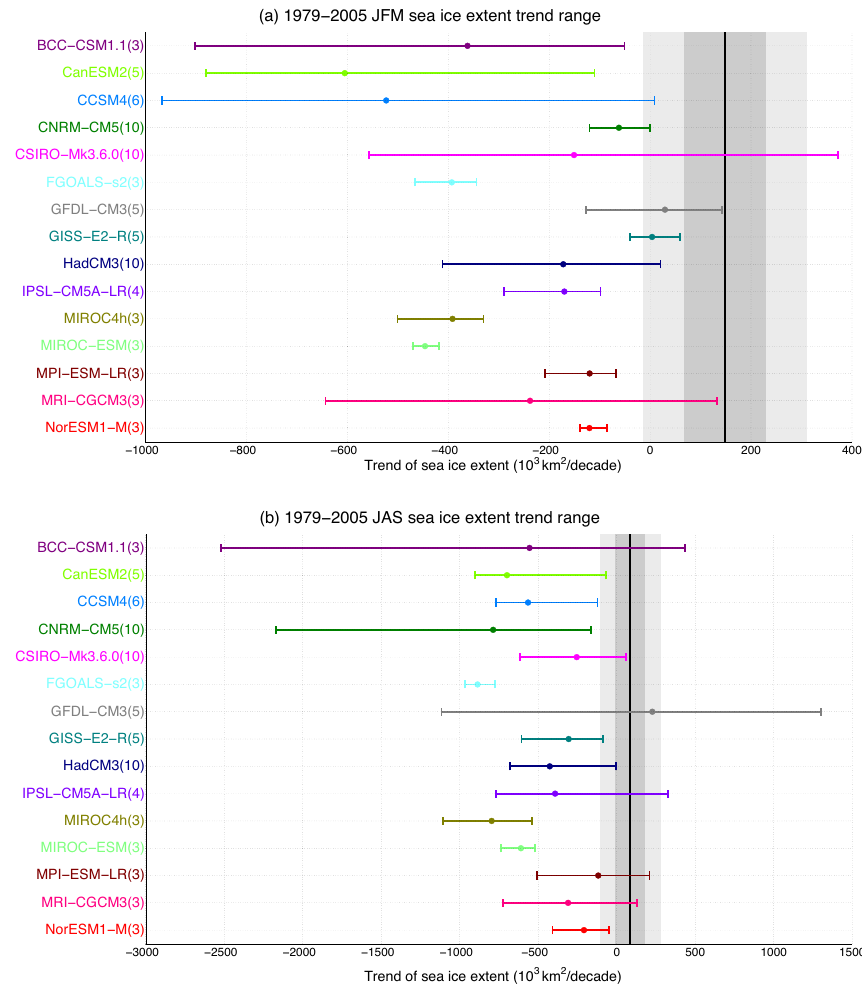
Fig. 4. Ensemble mean, minimum and maximum value of the sea ice extent trend for the period 1979–2005 over the whole Southern Ocean for summer (a) and winter (b) . The different colours correspond to the historical simulations from the 15 models that have at least 3 members in their ensemble. Dots refer to the ensemble means of the trends. Horizontal bars show the minimum and the maximum value of the trend reached by the members of one model ensemble. Solid black line is for the trend of the observations (Cavalieri and Parkinson, 2008) surrounded by 1 standard deviation (dark grey shade) and 2 standard deviations (light grey shade). The computed standard deviation of the observed trend takes into account the autocorrelation of the residuals (see for instance Santer et al., 2000; Stroeve et al.,